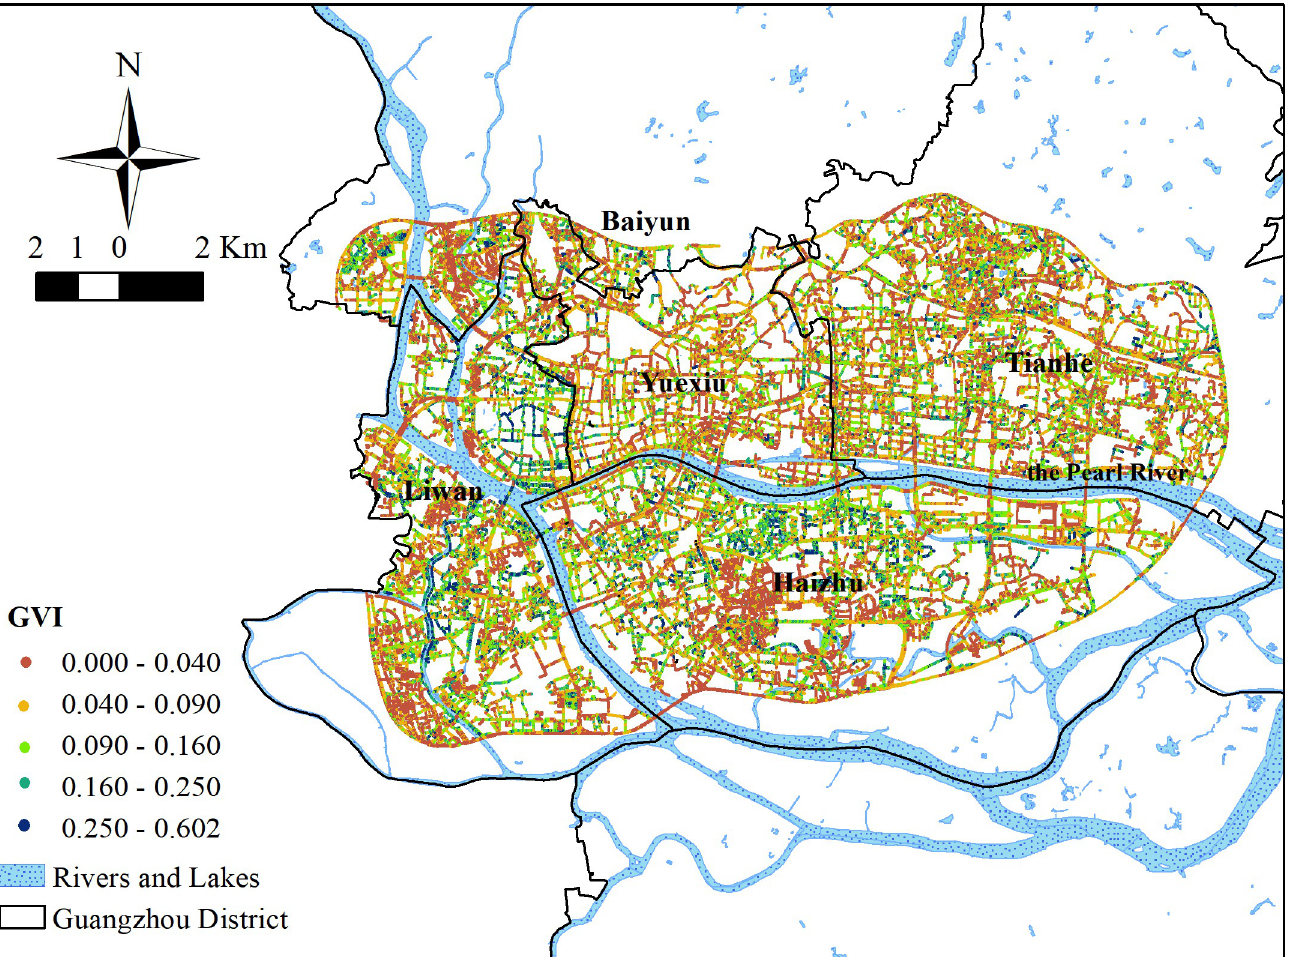
Fig 3. Distribution of GVI points in the study